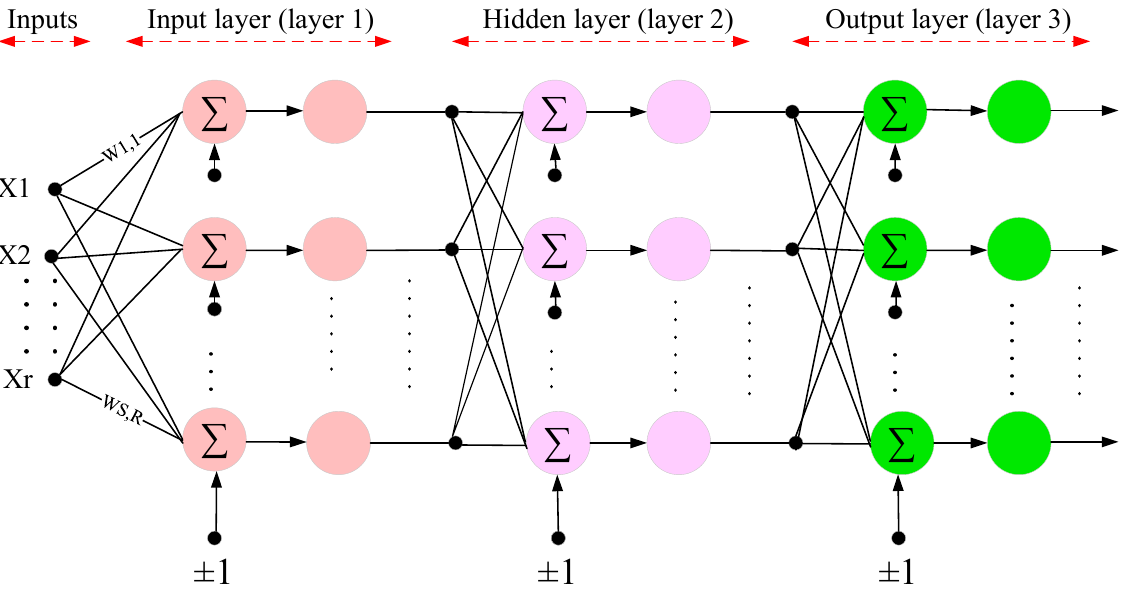
Figure 18. Sample of neural network.